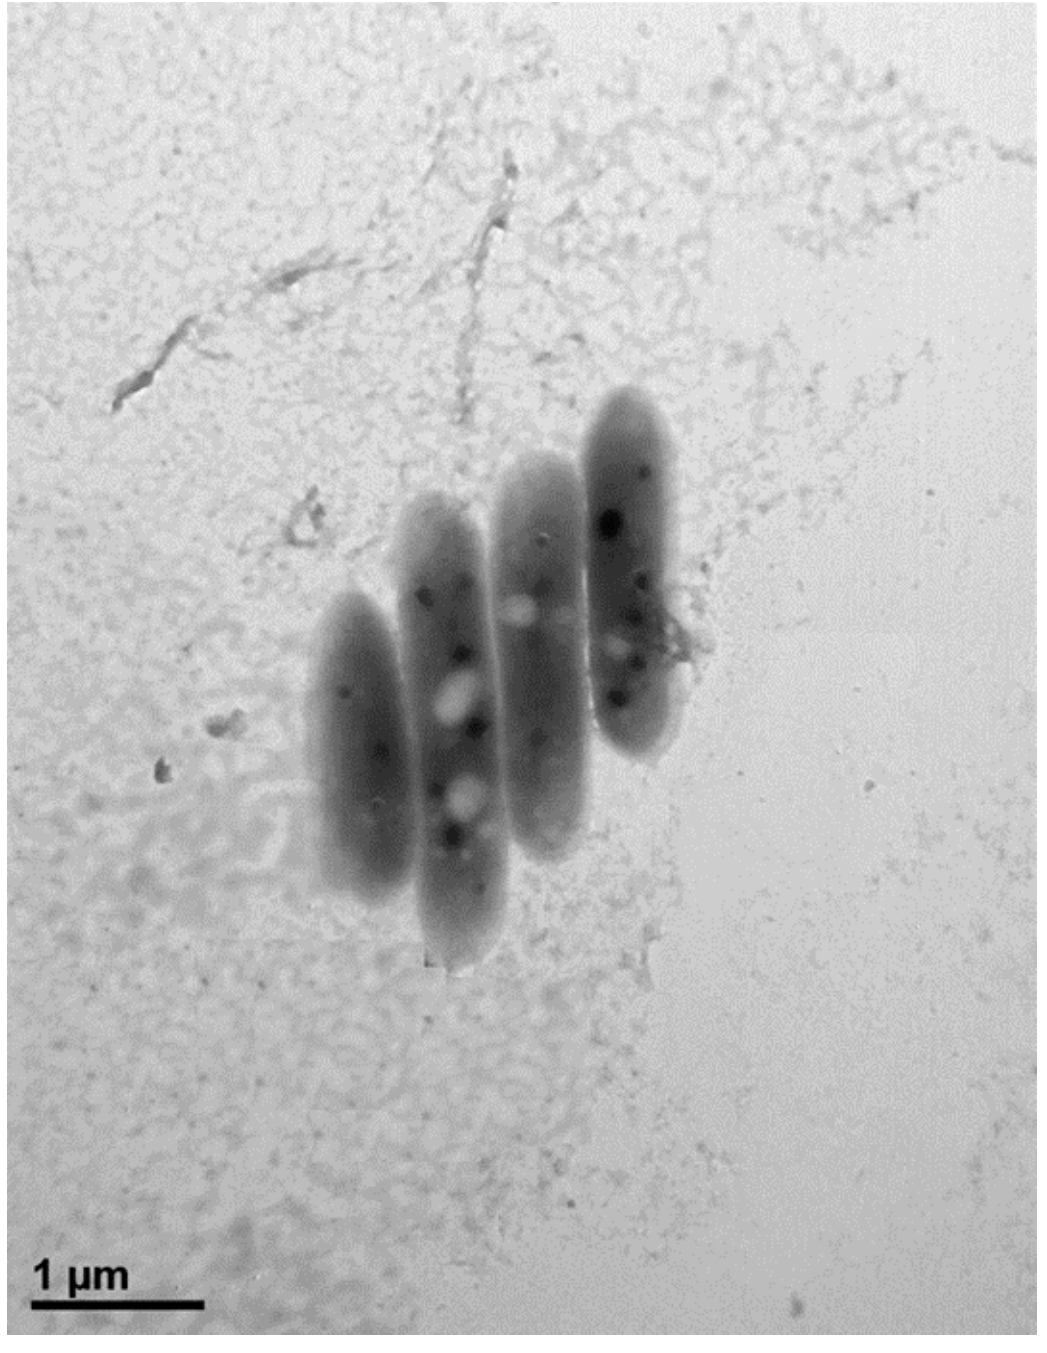
Figure 1. Transmission electron micrograph of cells of Terrabacter humi MAHUQ-38 T after negative staining with uranyl acetate, Bar, 1.0 μ m.